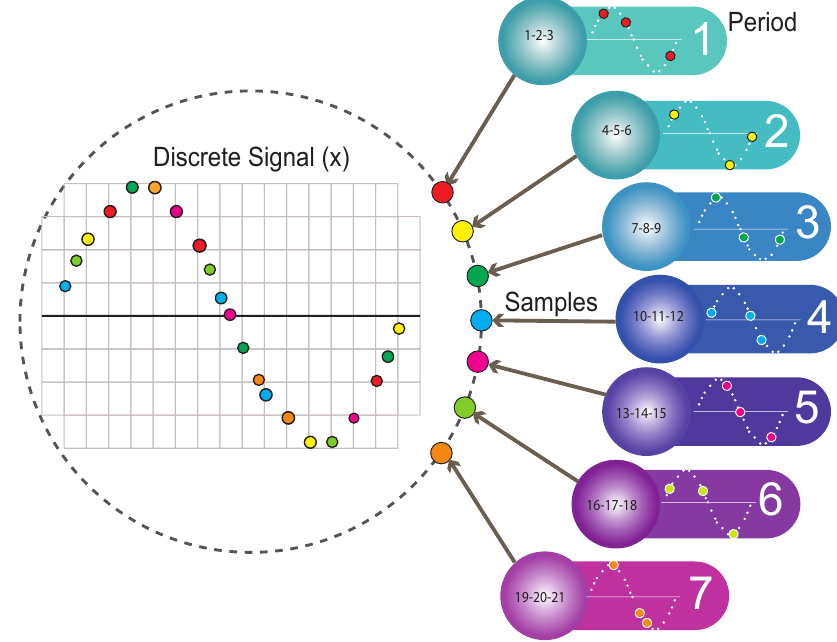
Figure 9. Signal reconstruction parameters and